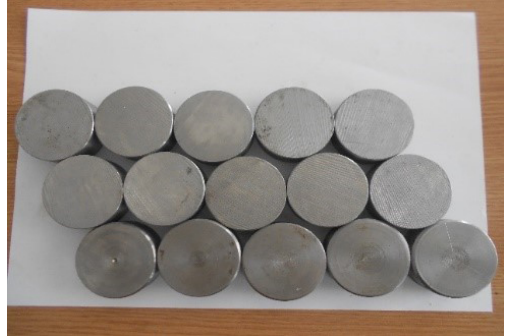
Figure 10. Machined part detail.